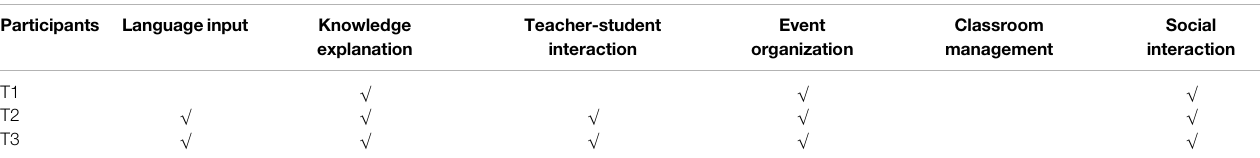
TABLE 2 | Teacher beliefs about the functions of